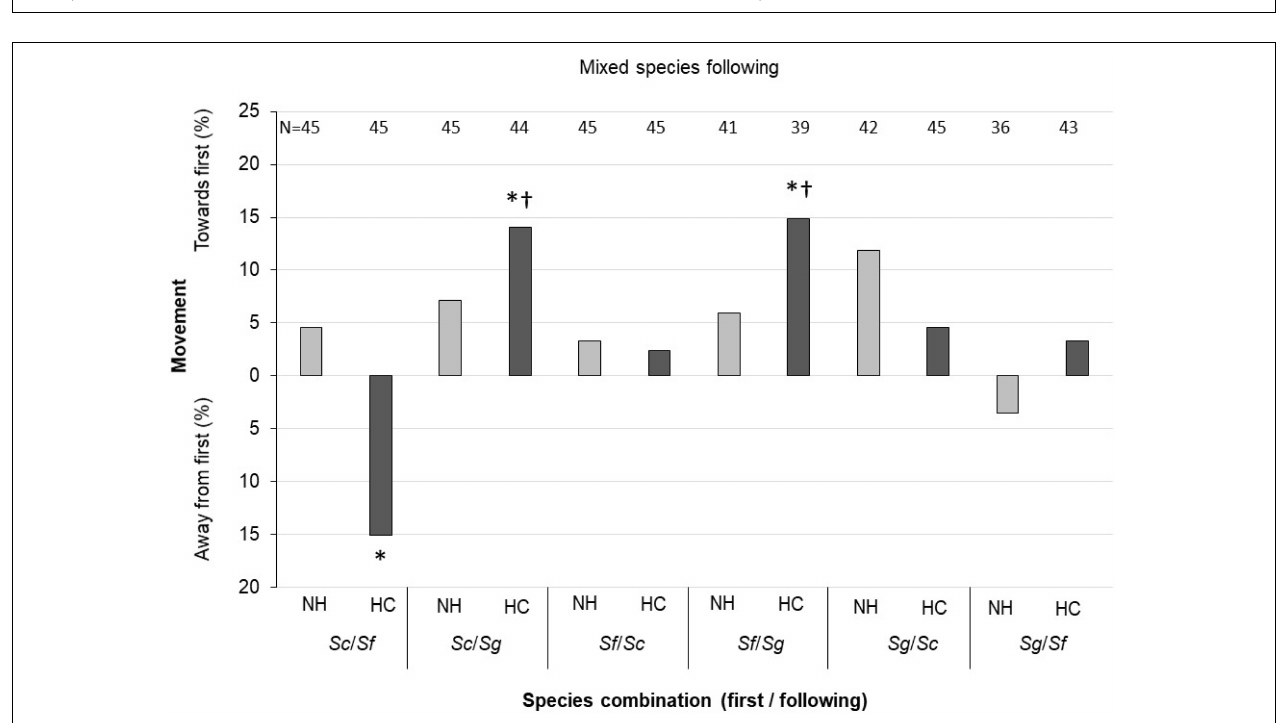
FIGURE 2 | Following results under single-species conditions. Binomial analysis, *** P < 0.001. Sample size for each condition listed above each bar; assays were attempted 45 times in all cases, but instances in which the lead IJ left the arena led to a total sample size of fewer than 45.